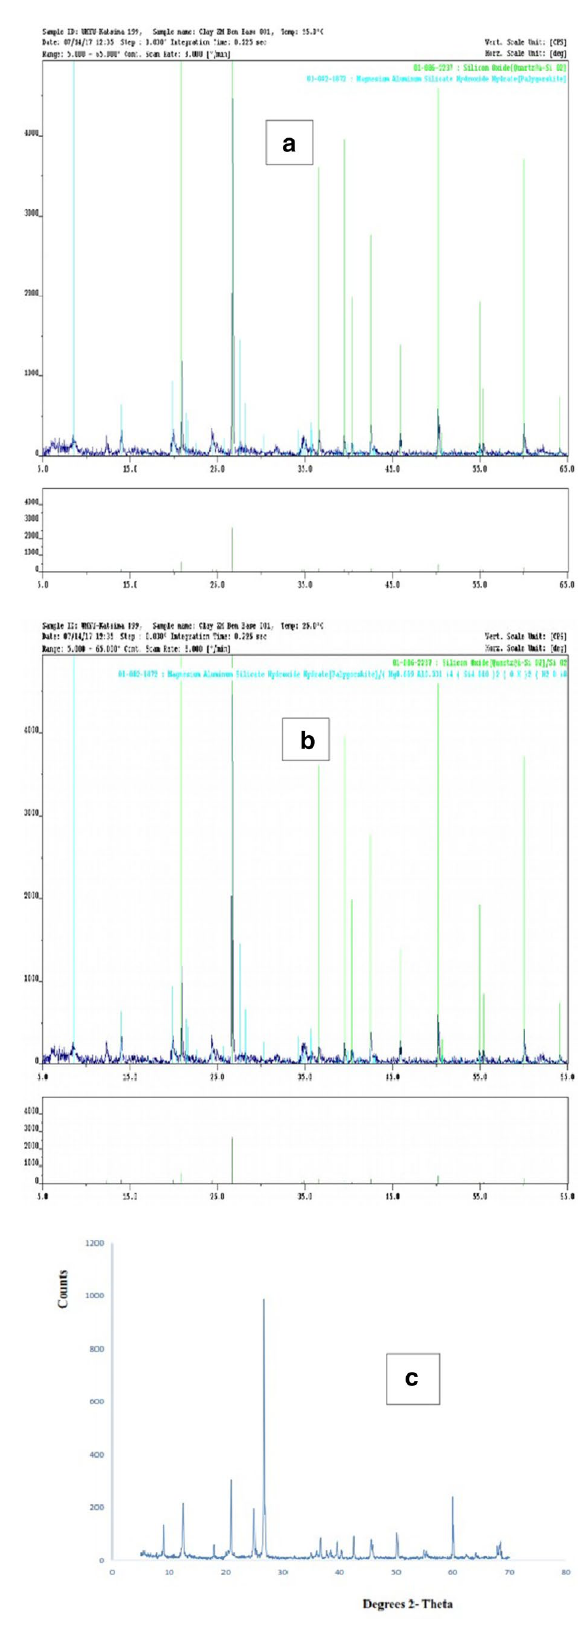
Fig. 8 XRD spectra of a 2-ABC, b 2-BBC and c